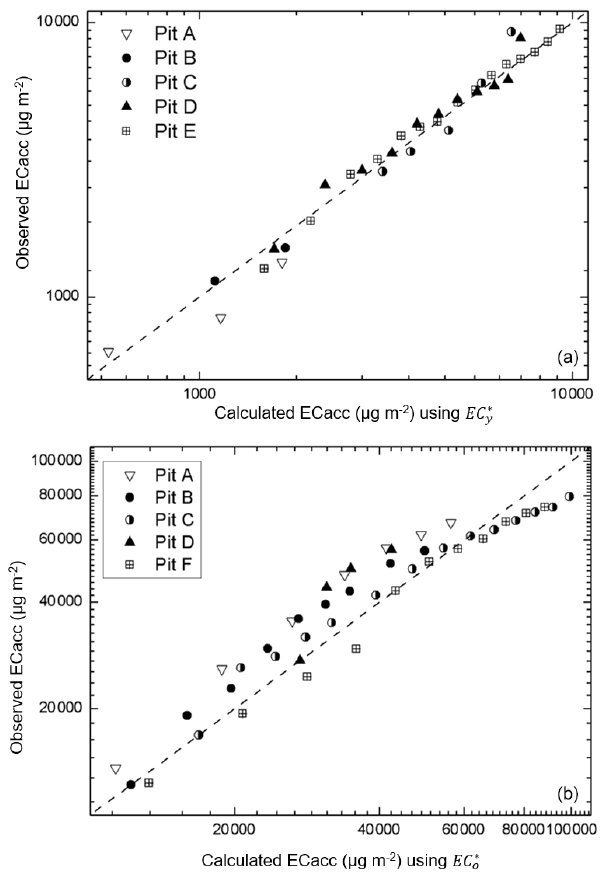
Figure 3. The observed and calculated deposition using the constant deposition EC ∗ y for young (a) and EC ∗ o for old (b) snow samples. Dashed lines indicate a 1 : 1 slope.